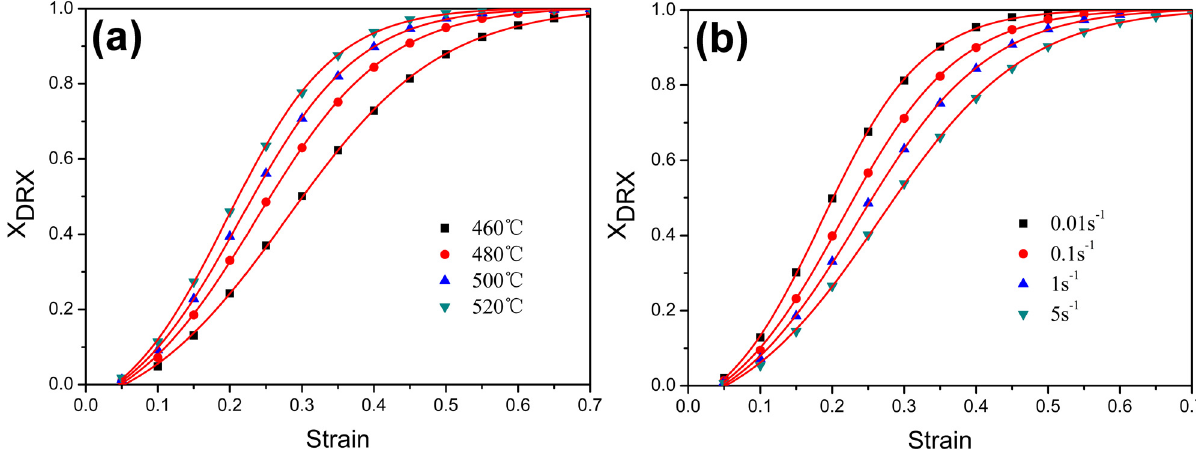
Figure 12: The relationship curves between X DRX and the strain based on equation ( 11 ) : ( a ) ε ̇ = 1 s − 1 and ( b ) T =